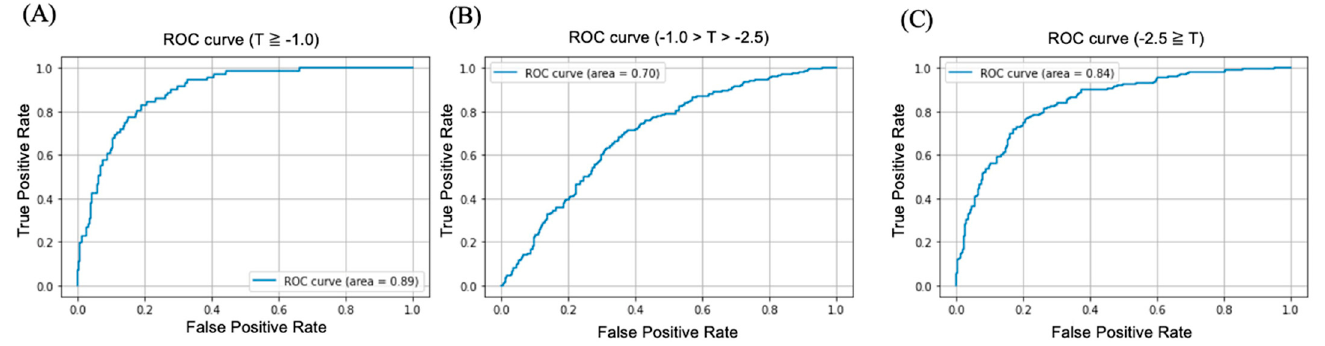
Figure 3. Receiver operating characteristic curve (ROC) for each class: ( A ) T-score greater than or equal to − 1.0; ( B ) T-score between − 1.0 and − 2.5; ( C ) T-score less than or equal to − 2.5.